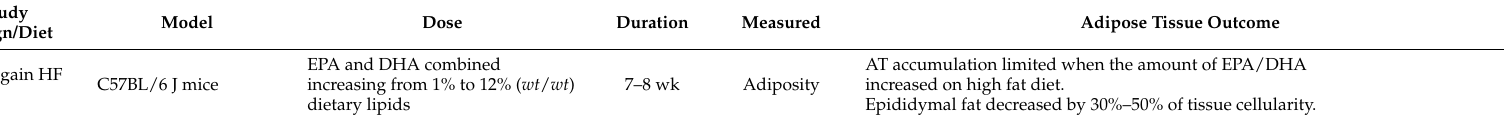
Table 3. Overview of animal studies investigating the effect of EPA and DHA supplementation on markers of adipose tissue metabolism and